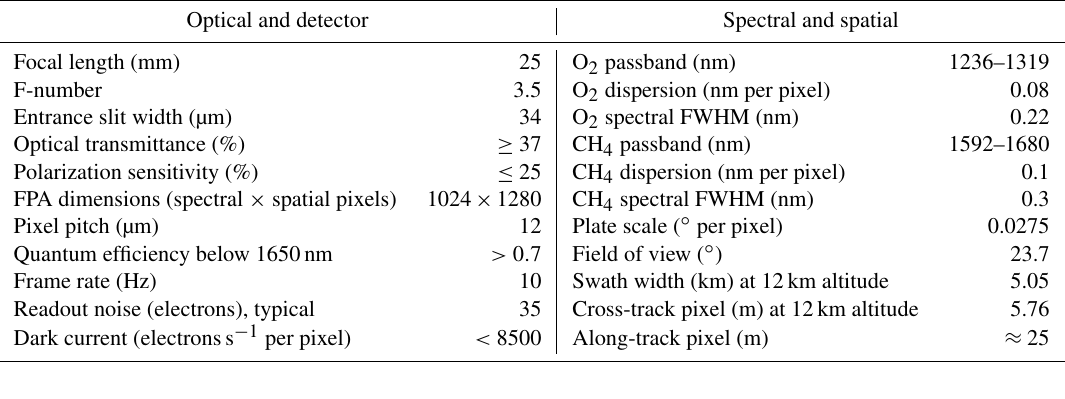
Table 1. MethaneAIR specifications.